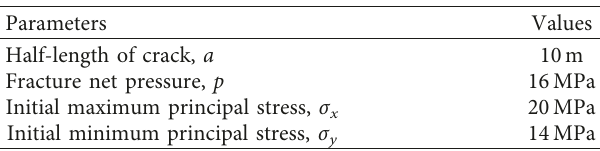
Figure 5: In situ stress after injection at point A ( x � 1, y � 10) and point B ( x � 10, y �